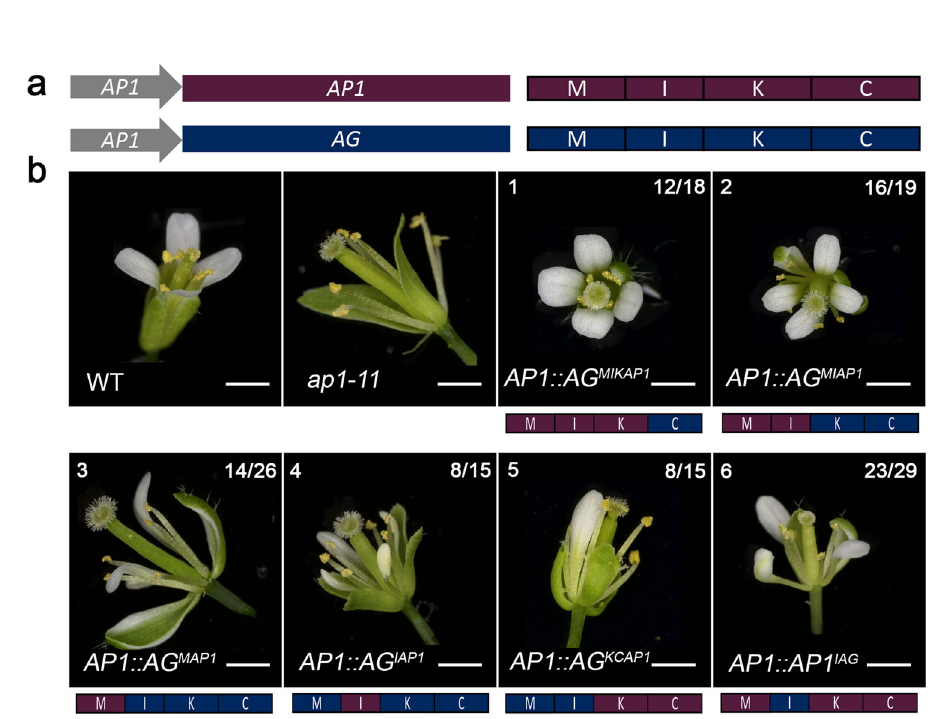
Fig. 5 Primary transformants in the ap1-11 mutant background exhibit a spectrum of complementation. a Schematic of the constructs and proteins produced with AP1 protein in purple and AG in dark blue. Domains are labelled MIKC. b Flower phenotypes of T1 transformants ( n ≥ 10). All transformants were in the ap1-11 background. Phenotypes for WT and ap1-11 are shown. The domains corresponding to AP1 and AG are coloured as per a and shown schematically below each panel labelled 1 – 6 in the top left. The number of primary transformants exhibiting a given phenotype is listed in the top right of panel 1 –